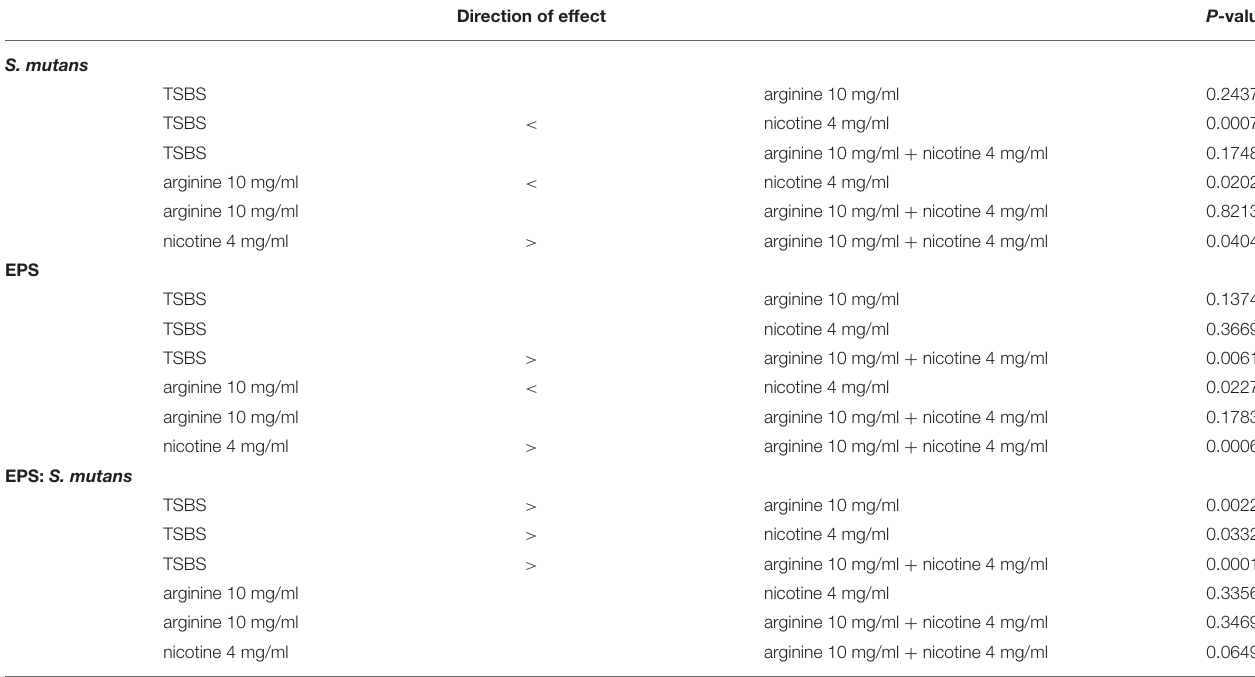
TABLE 5 | Pairwise comparisons of the effects of treatment on S. mutans , EPS and EPS: S. mutans ratio in biofilm as measured by CLSM in pixels. Direction of